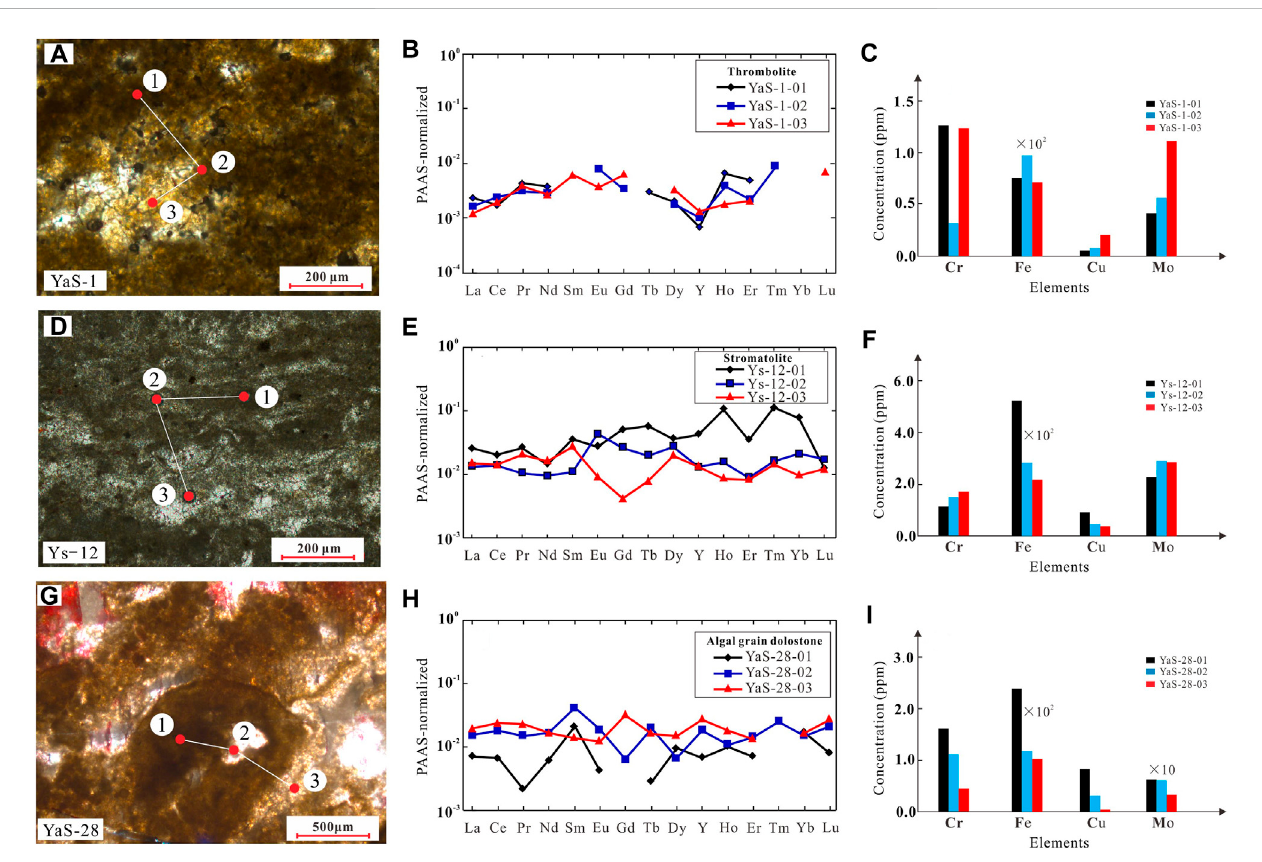
FIGURE 2 Geochemistry of speci fi c components of microbialites and cathodoluminescence microphotos of Member IV of the Leikoupo Formation. (A,D,G) Laser ablation locations for speci fi c components in Sample YaS-1, Ys-12, YaS-28, respectively; ① Microbial fabric, ② Transitional zone, ③ Fine spar fabric; (B,E,H) Shale-normalized REE+Y distribution patterns of speci fi c components of Sample YaS-1, YS-12, YaS-28, respectively (C,F,I) Trace elements (Cr, Fe, Cu, Mo) of speci fi c components in Sample YaS-1, YS-12, YaS-28,